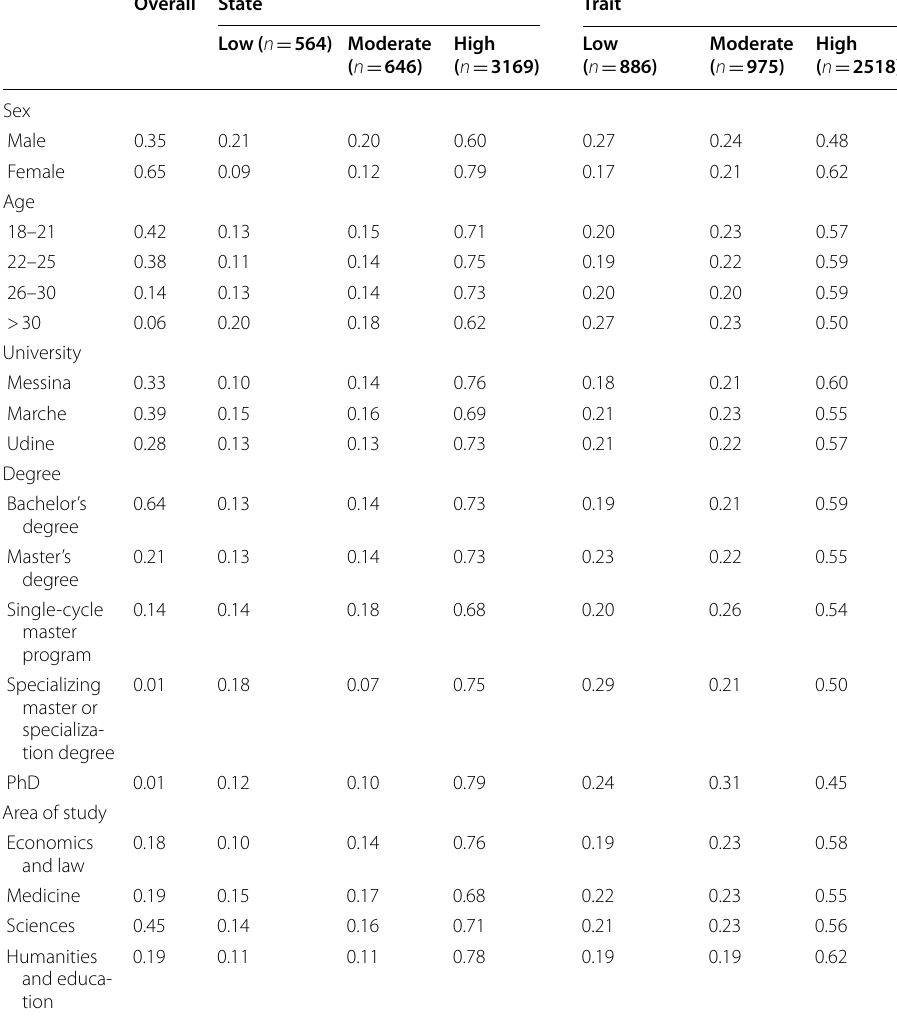
Table 2 Characteristics of the survey respondents by anxiety level Overall State